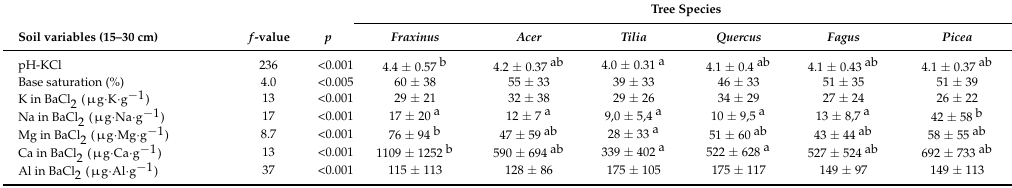
Table A4. Mean and standard deviation of the deeper soil (15–30 cm) properties for each tree species across all six common gardens. Significant differences according to the Tukey post-hoc test between tree species are indicated with letters, means with the same letter are not significantly different (Tukey 59 post-hoc tests on LME models, 1|Site). Figure 5. Relation between exchangeable Al concentration in the 0–5 cm soil layer ( a – c ) or Ca concentration in foliar litter ( d – f ), and density of anecic ( a , d ), endogeic ( b , e ), and epigeic ( c , f ) 60 earthworms. Plots where zero earthworms were found are indicated by a cross symbol. The foliar 61 litter Ca concentration was previously published by Vesterdal et al. [36]. 62